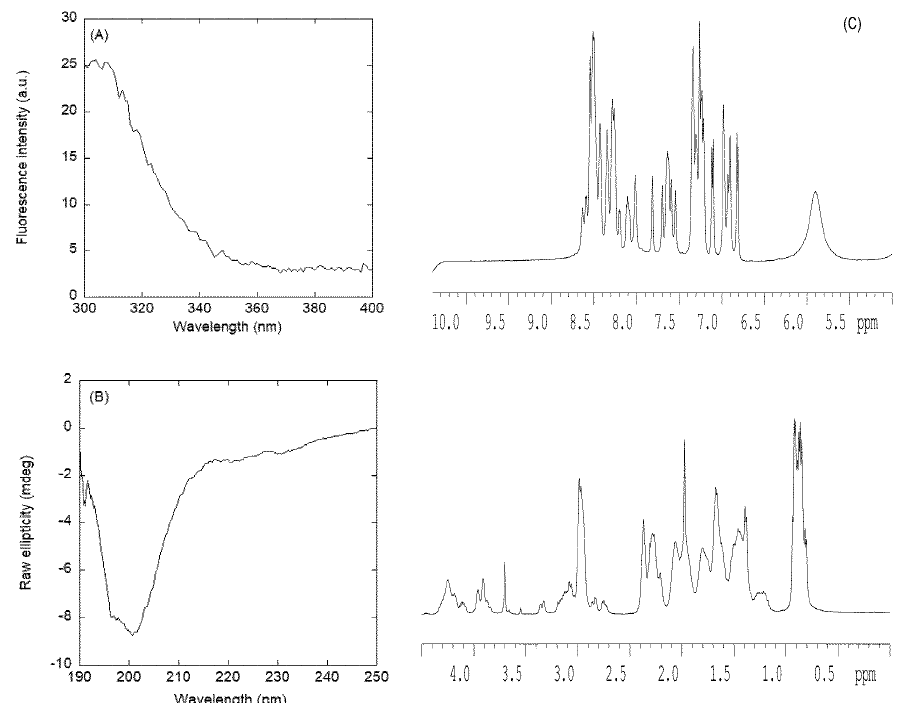
Figure 4. Conformational features of isolated NLS2-PADI4 in solution. ( A ) Fluorescence spectrum of NLS2-PADI4 in 20 mM Tris buffer (pH 7.5), 5 mM TCEP, 150 mM NaCl, and 5% glycerol at 25 °C. 25 ◦ C. ( B ) Far-UV CD spectrum of NLS2-PADI4 at 25 ◦ C in sodium phosphate buffer (50 mM, ( B ) Far-UV CD spectrum of NLS2-PADI4 at 25 °C in sodium phosphate buffer (50 mM, pH 7.5). ( C ) pH 7.5). ( C ) 1D- 1 H-NMR spectrum of isolated NLS2-PADI4 at 10 ◦ C and pH 7.0 (100 mM, sodium 1D- 1 H-NMR spectrum of isolated NLS2-PADI4 at 10 °C and pH 7.0 (100 mM, sodium phosphate phosphate buffer).